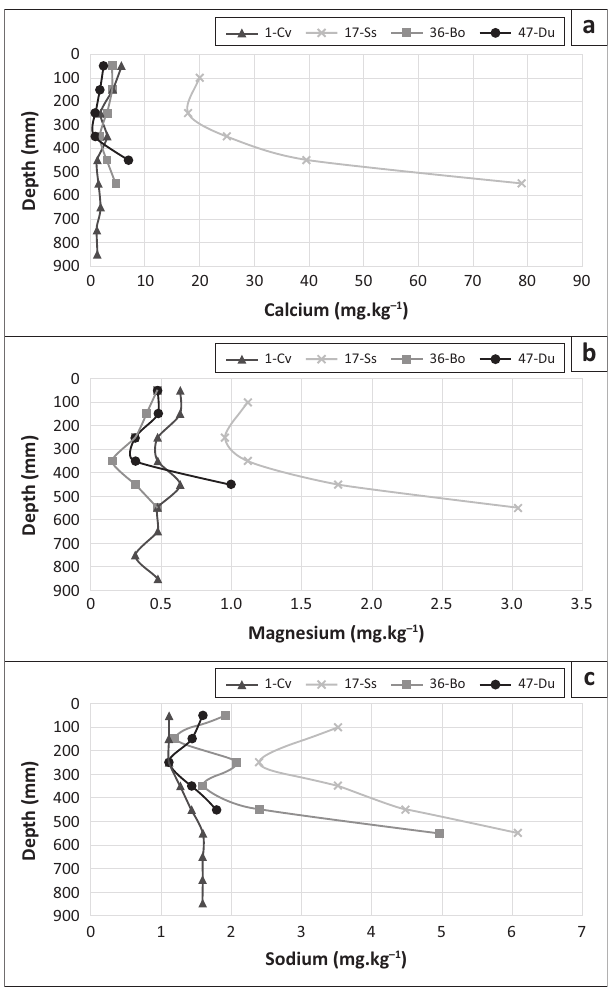
FIGURE 5: Soluble cation modal profiles: (a) calcium (Ca), (b) magnesium (Mg) and (c) sodium